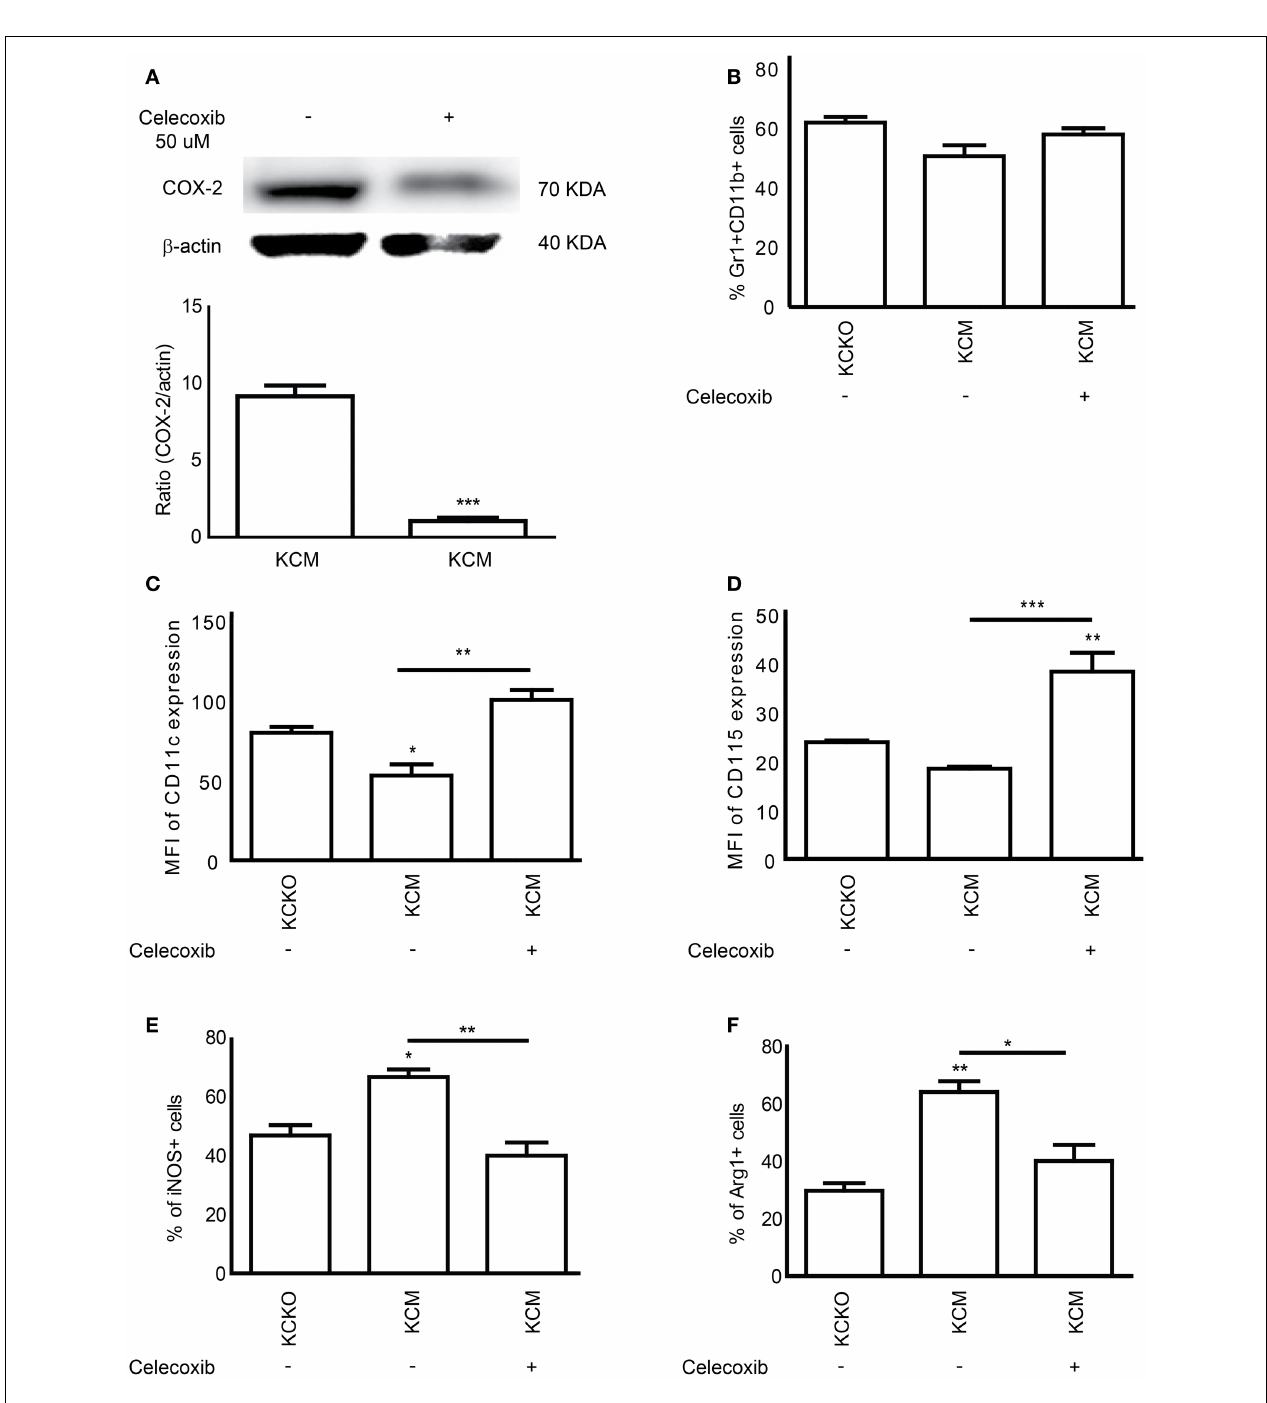
expression.Western blotting for COX-2 and β -actin protein expression was carried out 3 times; (B) Percentage of Gr1 + CD11b + MDSC population; (C,D) Expression of CD11c and CD115 expression on Gr1 + CD11b + cells; (E,F) Percentage of iNOS + and Arg-1 + cells on Gr1 + CD11b + gated cells. Percentages are not absolute numbers. Mean and standard error are shown. * p < 0.05, ** p < 0.01, and *** p < 0.001 for statistically significant differences from KCKO levels unless indicated by the line above the